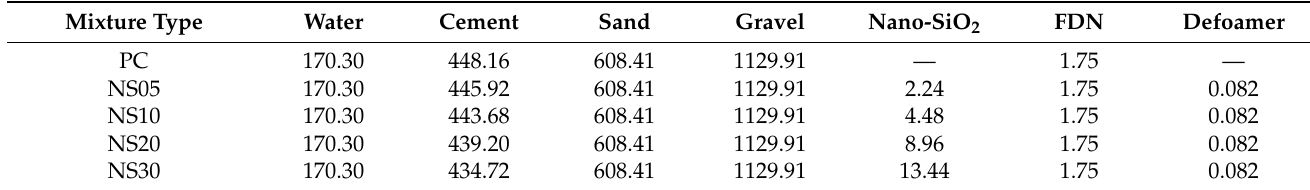
Table 3. Mix proportion of concretes (kg/m 3